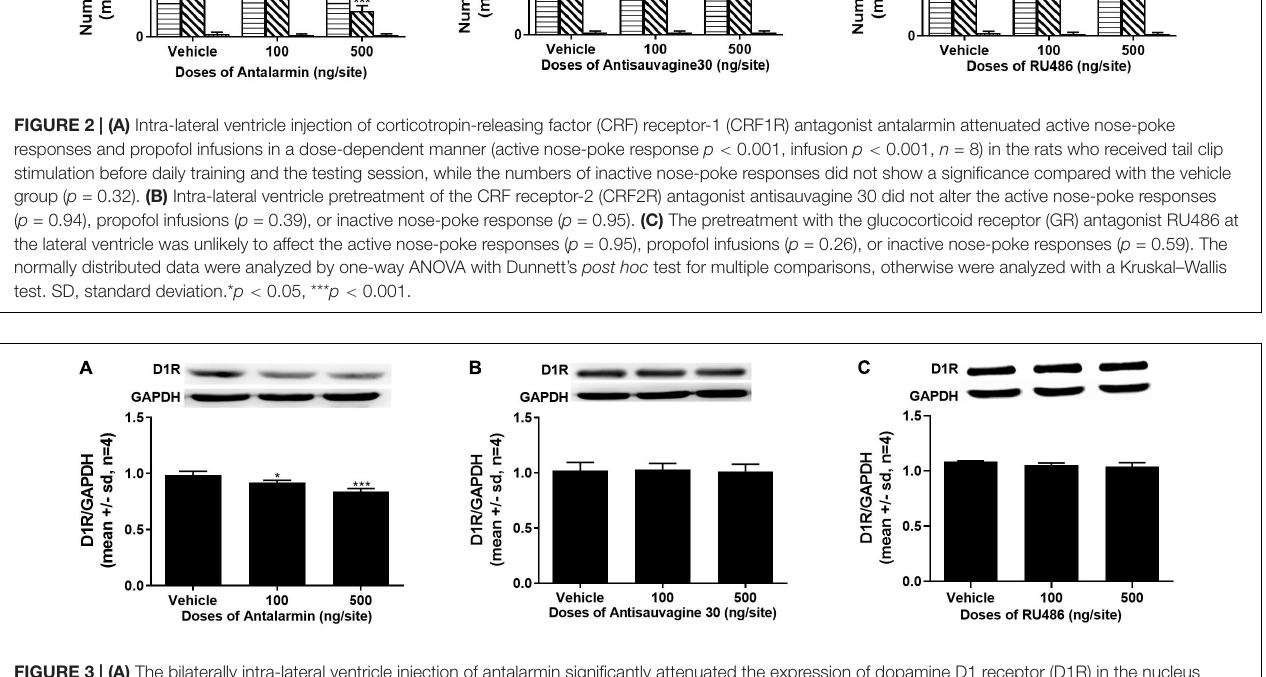
FIGURE 3 | (A) The bilaterally intra-lateral ventricle injection of antalarmin significantly attenuated the expression of dopamine D1 receptor (D1R) in the nucleus accumbens (NAc) at the doses of 100 ng/site ( p = 0.016) and 500 ng/site ( p < 0.001) in the rats who received tail clip stimulation prior to daily training and the testing session ( n = 4). (B) The expression of D1R in the NAc was not altered by the pretreatment of antisauvagine 30 at the bilateral lateral ventricle ( p = 0.92). (C) The pretreatment with RU486 at the bilateral lateral ventricle did not significantly change the D1R expression in the NAc ( p = 0.070). The data was analyzed with one-way ANOVA with Dunnett’s post hoc test for multiple comparisons. SD, standard deviation. * p < 0.05, *** p < 0.001.